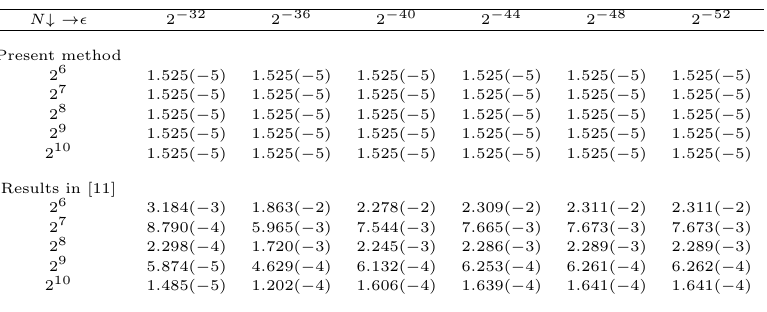
Table 1. Maximum absolute errors in the solution of Example 1